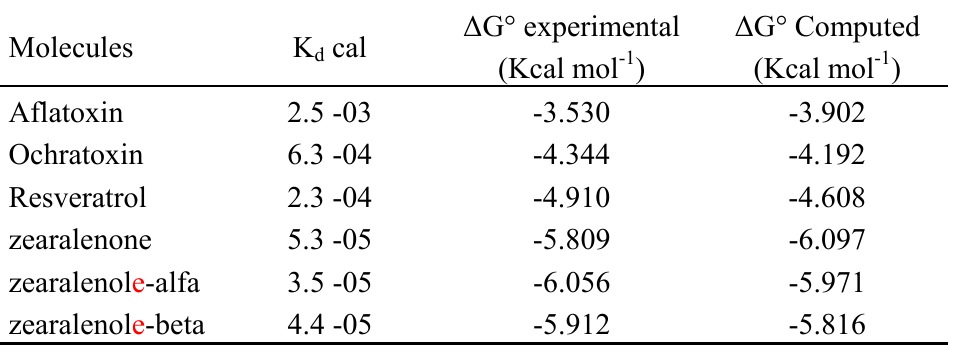
Table 2. Experimental K , experimental Δ G° and predicted Δ G° for six new ligands. d